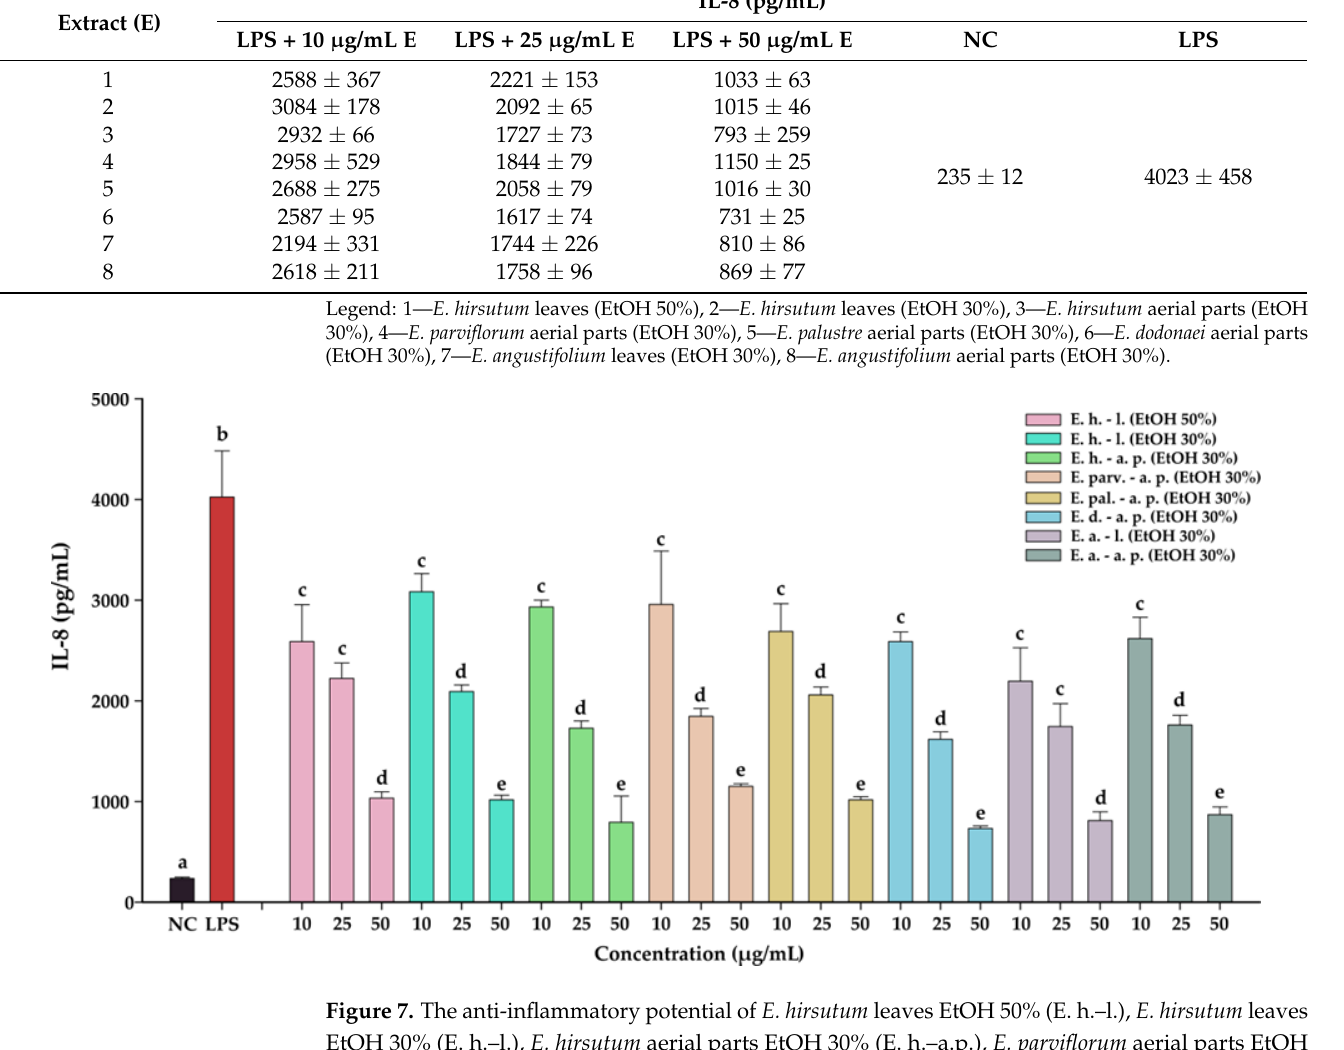
Figure 8. The anti-inflammatory potential of E. hirsutum leaves EtOH 50% (E. h. – l.), E. hirsutum leaves EtOH 30% (E. h. – l.), E. hirsutum aerial parts EtOH 30% (E. h. – a.p.), E. parviflorum aerial parts EtOH 30% ( E. parv. – a. p.), E. palustre aerial parts EtOH30% (E. pal. – a. p.), E. dodonaei aerial parts EtOH 30% (E. d. – a. p.), E. angustifolium leaves EtOH 30% (E. a. – l.), and E. angustifolium aerial parts EtOH 30% (E. a. – a. p.). The quantity of IL-8 was measured from cellular supernatants after a 24 h exposure to the extracts (10, 25, and 50 µg/mL) in combination with 100 ng/mL LPS. Different lowercase letters for bars representing the same extract and shown in identical colors indicate statistically significant differences in measured cytokine amounts (ANOVA + Holm- Sidak post hoc test at p<0.05 level of significance)